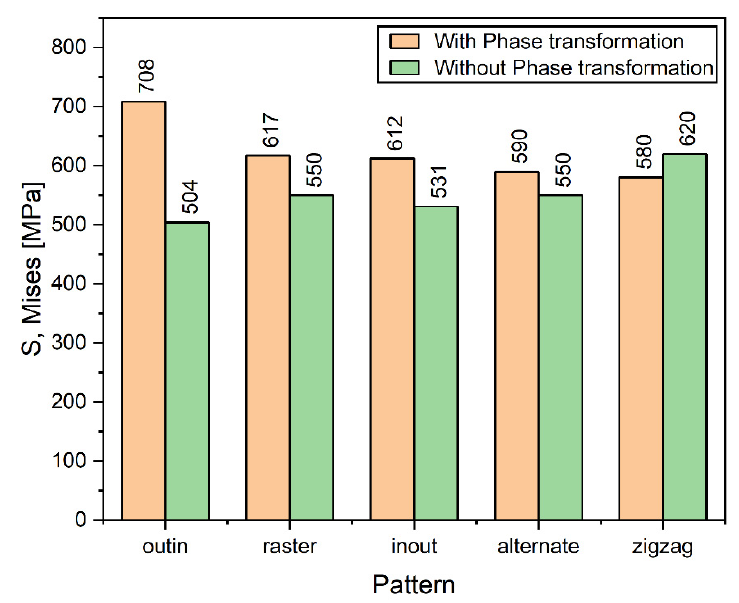
Figure 11. Comparison of maximum Mises stress of different deposition patterns at the end of the simulation.